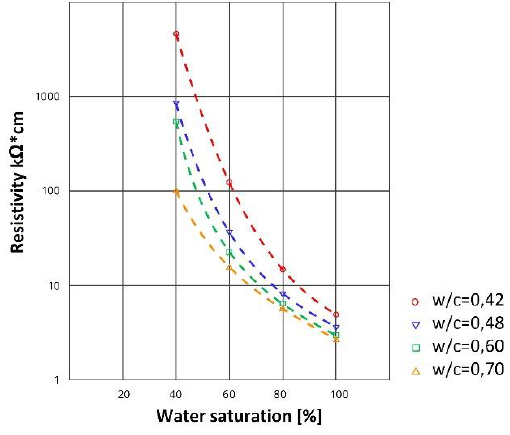
Figure 2. Relationship between saturation and resistivity of concrete [15].